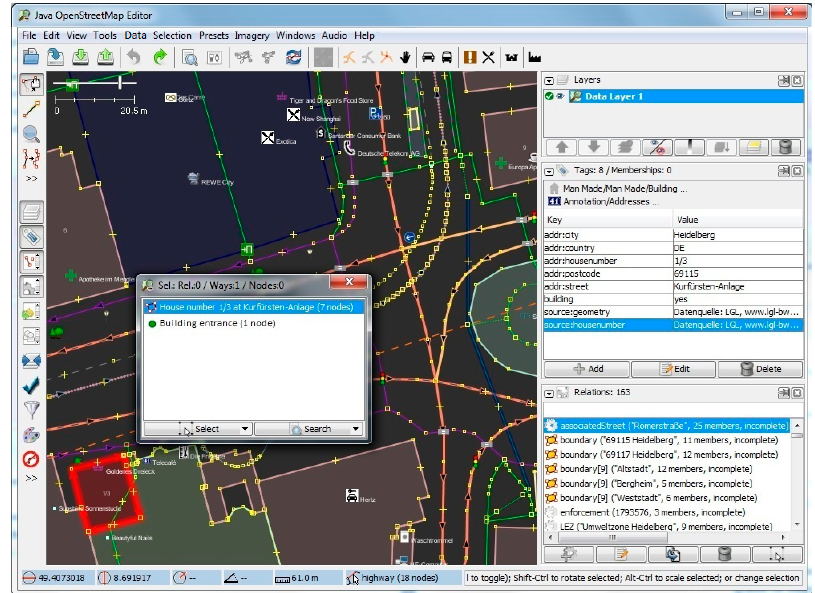
Figure 10. Enriched Semantic Query-Enhanced Web Rule Language (SQWRL) query to derive building entrances.